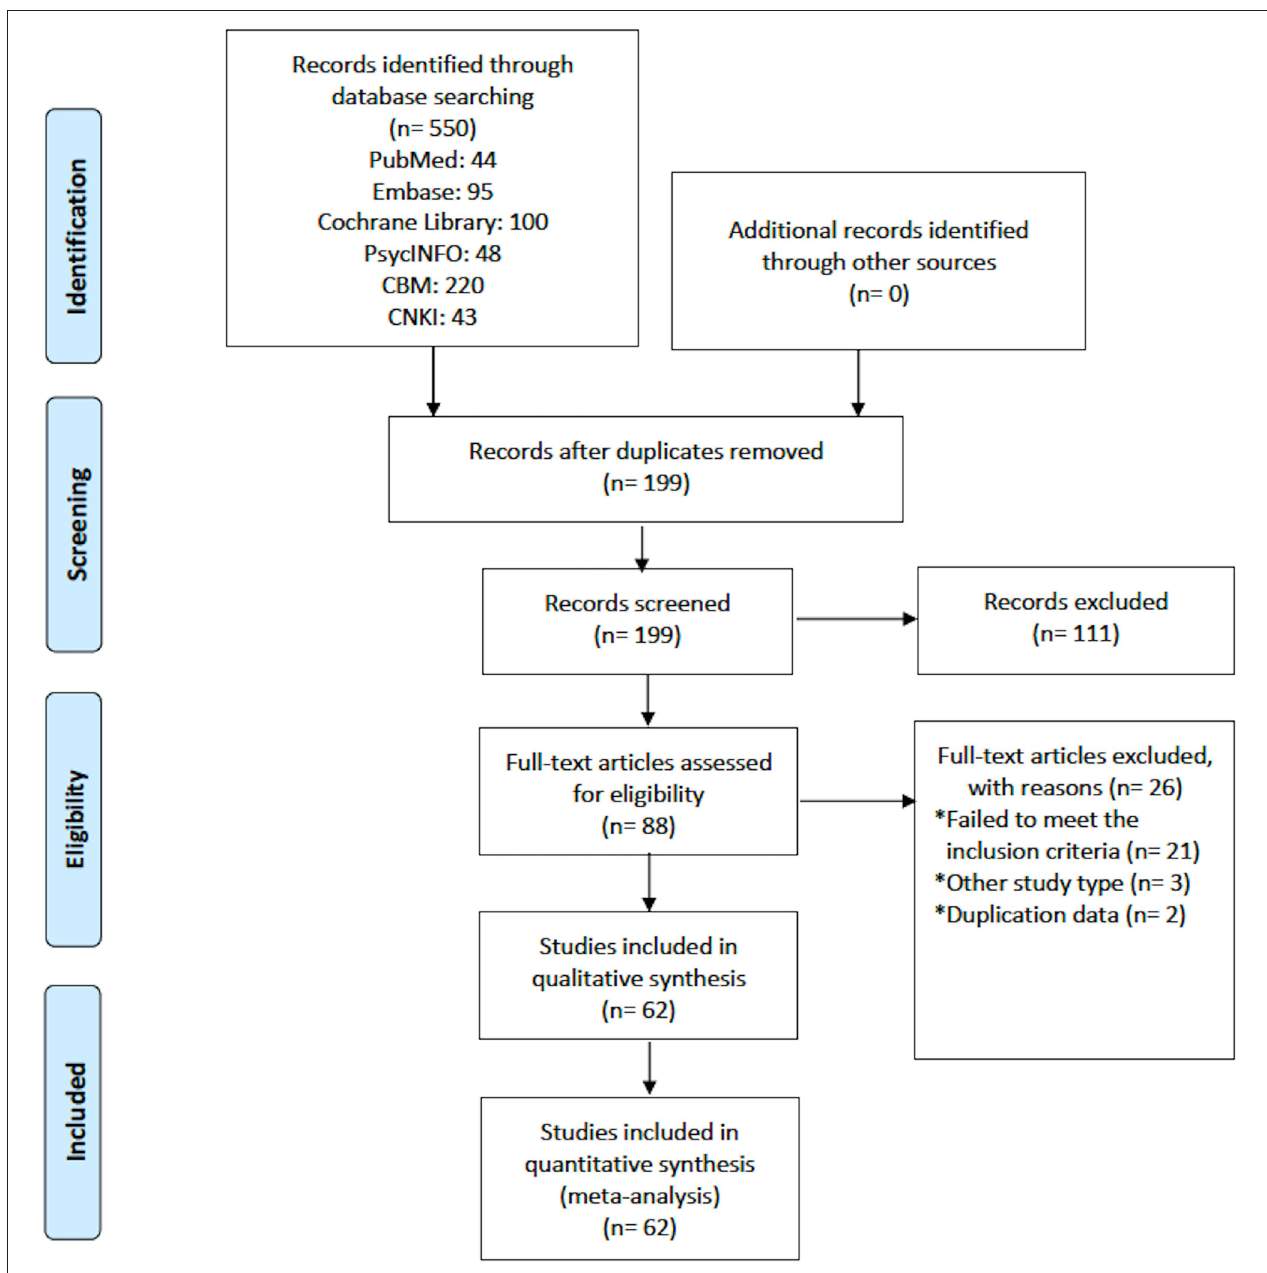
FIGURE 1 | Flow chart of included